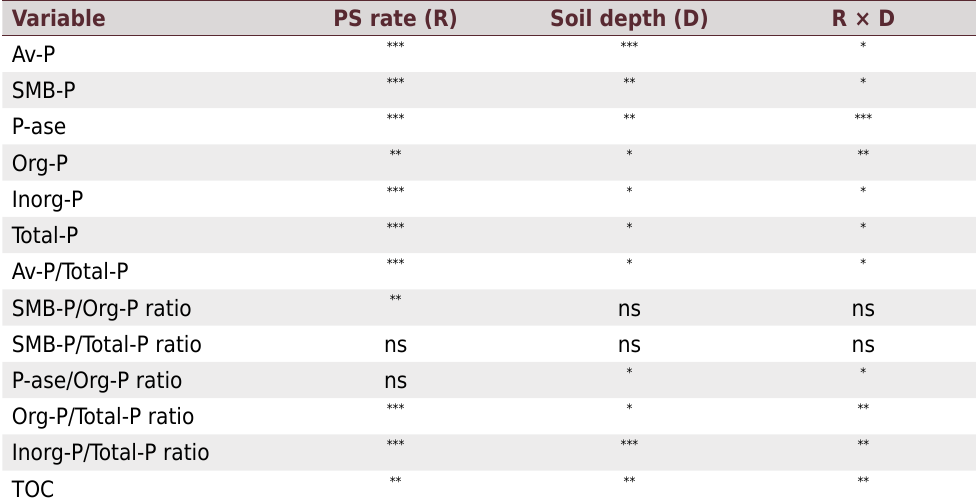
Table 3. Analysis of variance (ANOVA) for different P pools in response to different PS rates application (R), soil layers (D) and their interaction (R × D)